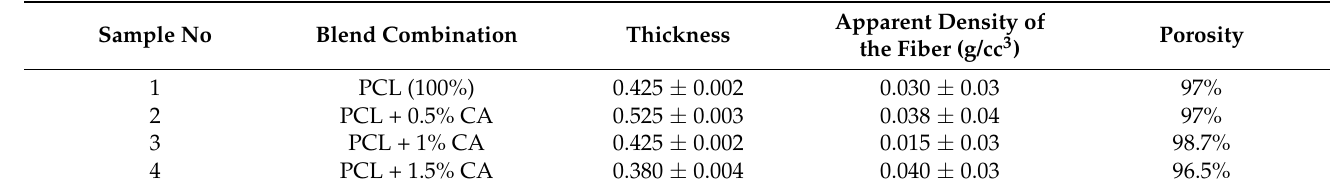
Table 2. Porosity, thickness, and density of c-spun PCL and PCL-CA fibrous mats with different blend ratios.